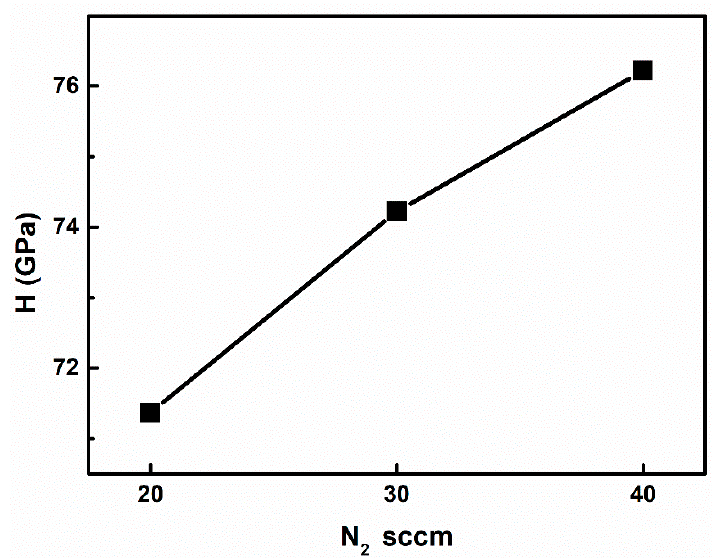
Figure 7. Hardness measurement plot of AlN thin films by varied N 2 flow rate from 20 to 40 sccm. 3.5. XRD and Photoluminescence Spectroscopy for Si/GaN and Si/AlN/GaN AlN thin film produced with optimized sputtering parameters was used as the buffer layer for subsequent sputtering growth of GaN thin films on Si substrate; this Si/AlN/GaN thin film was compared with GaN sputtered directly on Si (Si/GaN). Figure 8 displays the XRD measurements for Si/GaN and Si/AlN/GaN and reveals GaN (002) and (103) phase orientations at 34 ◦ and 63 ◦ , respectively, for both samples. The obtained peaks formed in the hexagonal wurtzite phase and can be verified using the JCPDS card No. 01-089-7522. The intense and sharp peak at 34 ◦ indicates that the GaN crystals formed along the c -axis, confirming their (002) orientation [23]. A narrower GaN (002) peak, as indicated by a lower FWHM, indicates superior grain formation. The FWHMs for Si/GaN and Si/AlN/GaN were 3.99 ◦ and 1.03 ◦ , respectively. Thus, using AlN as a buffer layer improves GaN crystal formation.